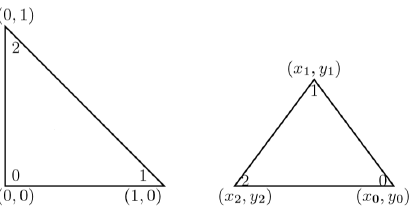
Figure 10. ( Left ) The reference element; ( right ) an arbitrary